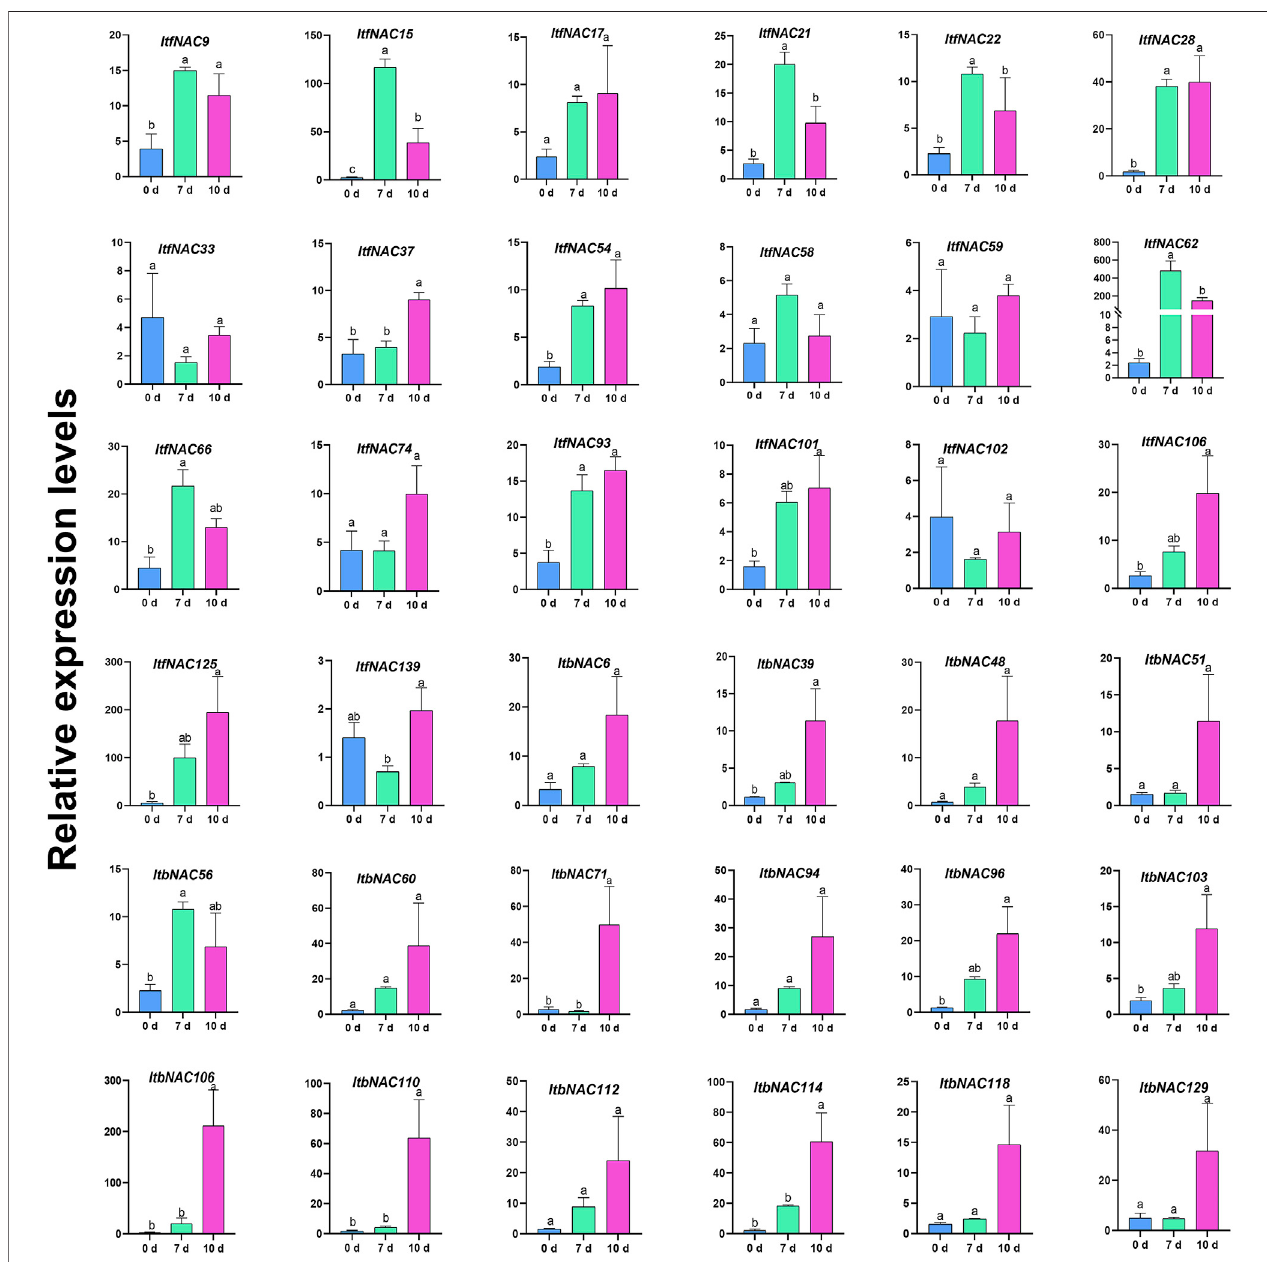
FIGURE 11 | RT-qPCR expression analysis of 36 selected NAC TFs in hexaploid cultivated sweet potato plants subjected to drought stress for 0, 7, and 10 days. Three independent biological replicates and three technical replicates for each biological replicate were carried out in RT-qPCR experiments. Different letters denote signi fi cance at p < 0.05 using Duncan ’ s multiple range